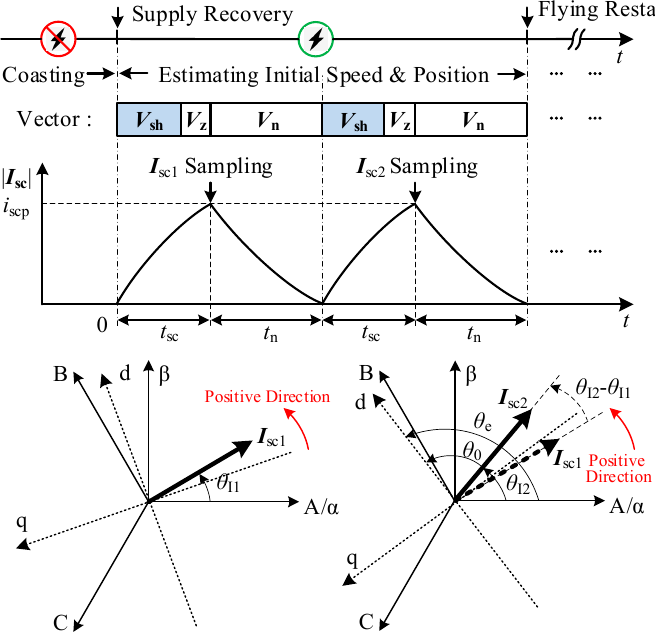
Figure 7. Principle of obtaining initial speed and rotor position under the proposed SZVSM. As shown in Figure 7, | I sc | is the amplitude of stator phase current vector; i scp is the peak value of the short-circuit phase current vector’s amplitude; I sc1 and I sc2 represent short-circuit phase current vectors after the first and second actions of the shoot-through vector and zero vector, respectively; θ I1 and θ I2 are the phase angles of I sc1 and I sc2 relative to axis A in the three-phase stator coordinate system, respectively; θ 0 is the phase angle of I sc2 relative to d-axis in dq coordinate system; and θ e is the rotor position angle.